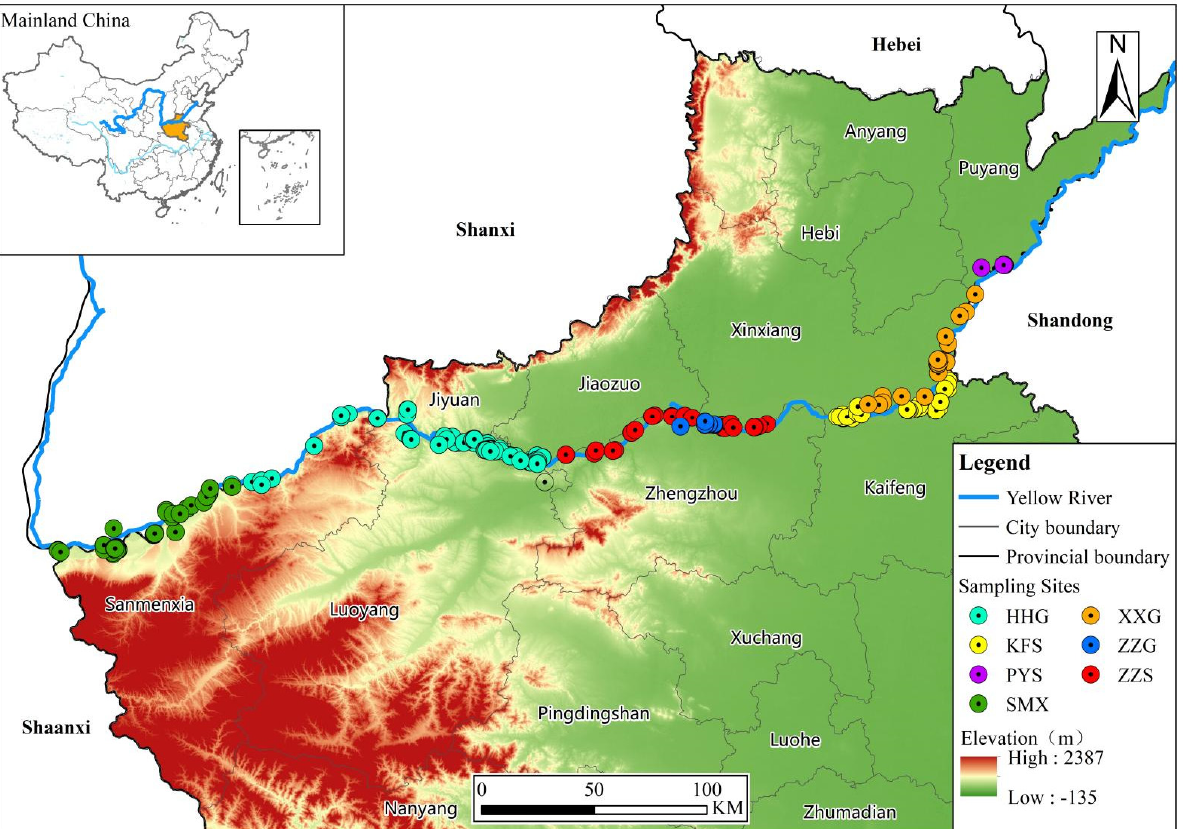
Figure 1. Geographical location distribution of the group of the 830 quadrats set in this study. HHG, Henan Yellow River wetland national nature reserve. SMX, Sanmenxia reservoir area wetland. ZZS, Henan Zhengzhou Yellow River wetland provincial nature reserve. ZZG, Henan Zhengzhou Yellow River national wetland park. KFS, Henan Kaifeng Liuyuankou wetland provincial nature reserve. XXN, Henan Xinxiang Yellow River wetland birds national nature reserve. PYS, Henan Puyang Yellow River wetland provincial nature reserve.